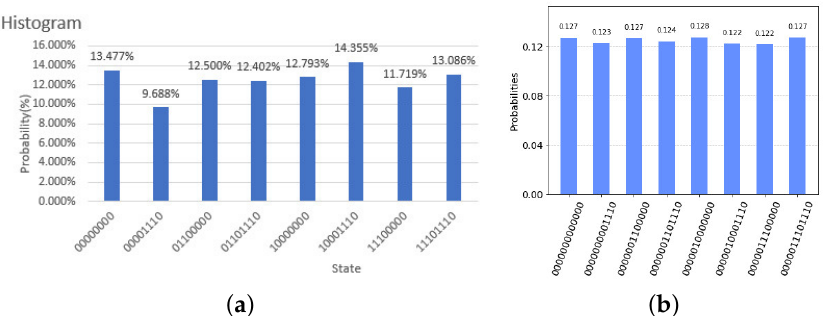
Figure 5. Histogram of output results. ( a ) Histogram of output results after running once in the ’ibmq_qasm_simulator’ quantum processor. The x-axis of this histogram is arranged in the order of ( 8, · · · 2,1 ) from the bottom to the top. ( b ) Histogram of output results after running ten times in Jupyter Notebook. The x-axis of this histogram is arranged in the order of ( c (cid:48)(cid:48)(cid:48) , b (cid:48)(cid:48) , · · · 2,1 ) from the bottom to the top.